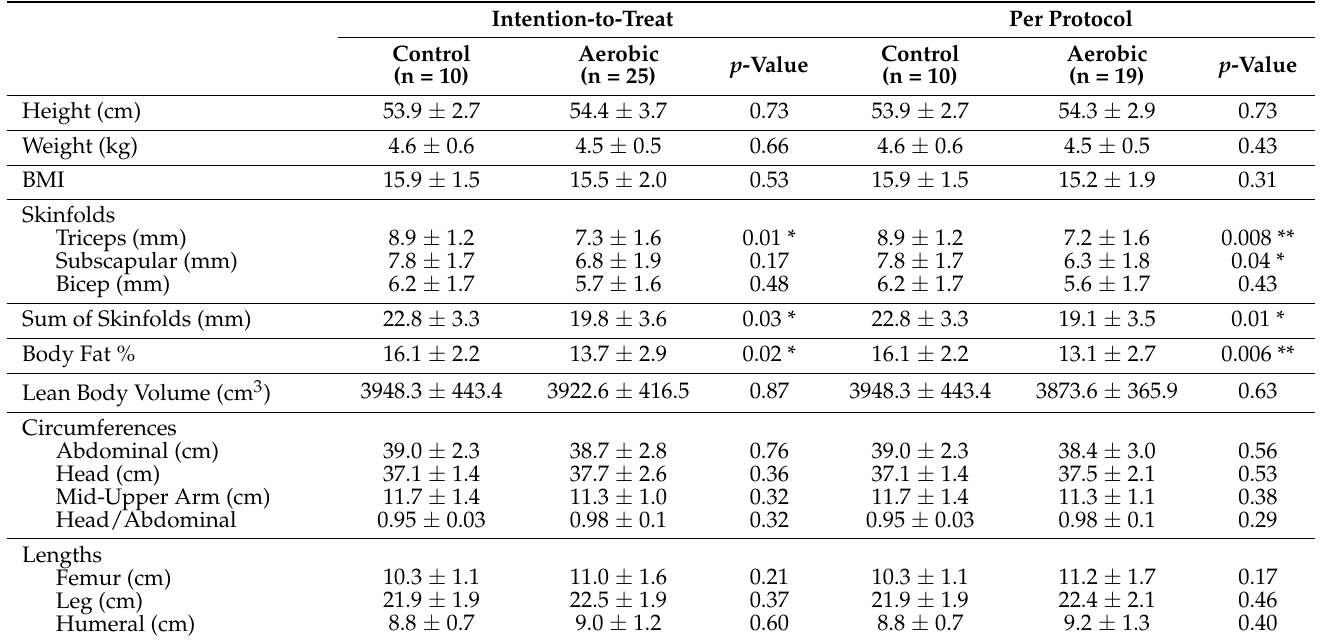
Table 3. Intention-to-treat and per protocol analyses of infant body composition measures between aerobic exercise and non-exercising